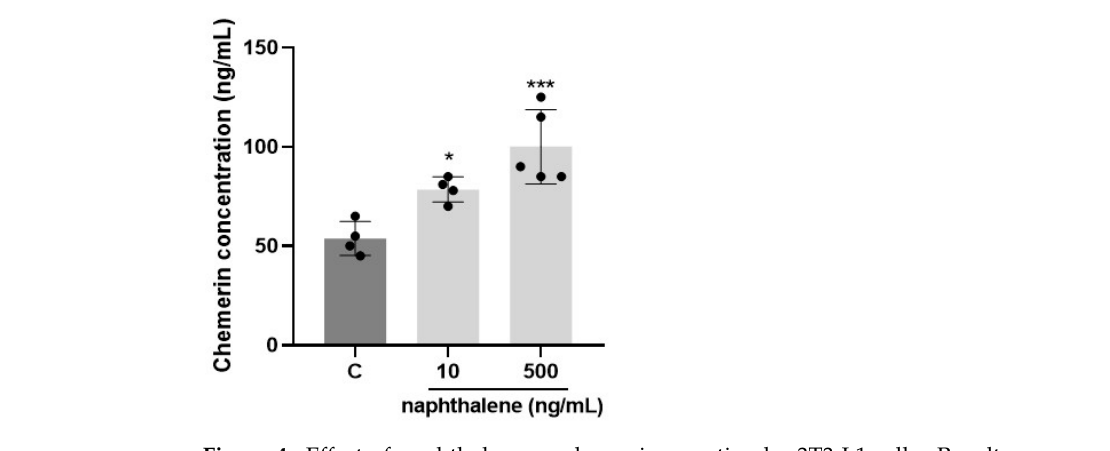
Figure 4. Effect of naphthalene on chemerin secretion by 3T3-L1 cells. Results are expressed as mean ± SEM ( n = 6) from three independent experiments. The means of each group were compared to those of control group. * p < 0.05, *** p < 0.001.